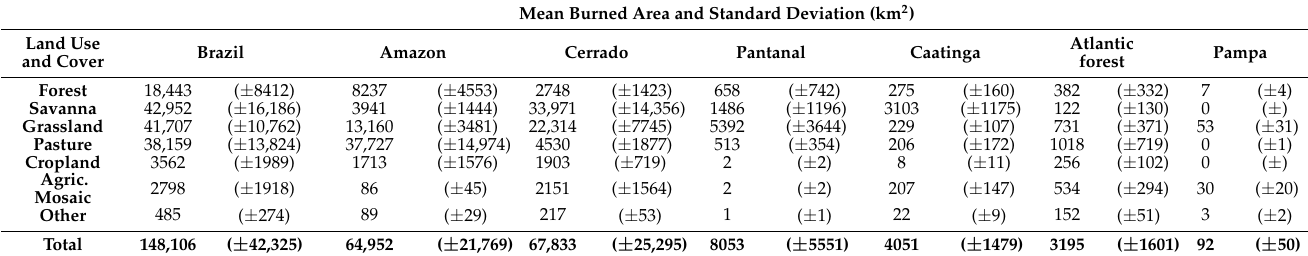
Table 3. Mean burned area and standard deviation in the main land use and cover classes in Brazil and the Brazilian